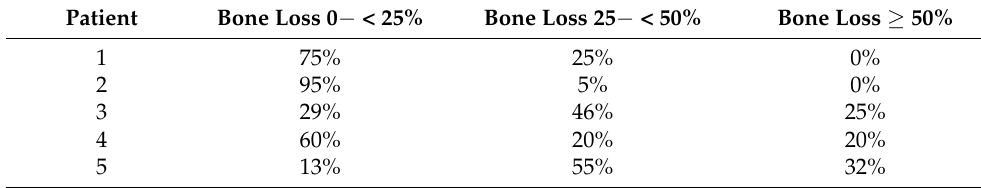
Table 3. Bone loss around implants (bone loss in % around implant [distance implant shoulder— implant apex], mesial and